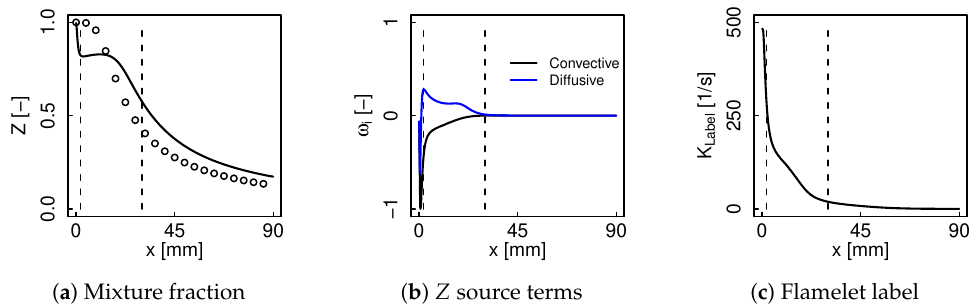
Figure 2. Centerline profiles of mixture fraction, normalized model correction terms and strain rate for ∆ = 2 mm. Solid lines represent the filtered tabulated chemistry results, circles correspond to the reference solution. The convention [–] is employed to denote non-dimensional